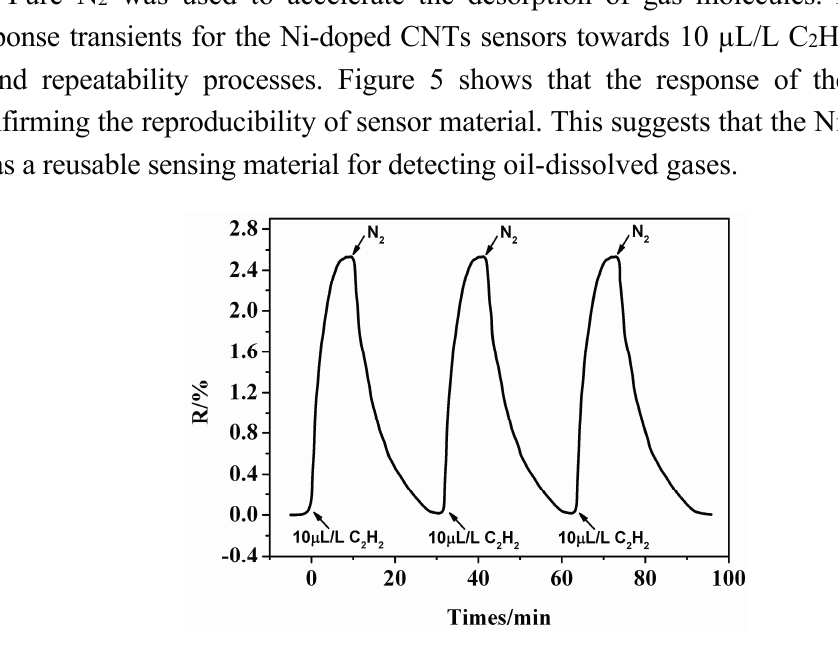
Figure 5. Reproducibility of Ni-doped CNTs sensor to 10 µL/L C 2 H 2